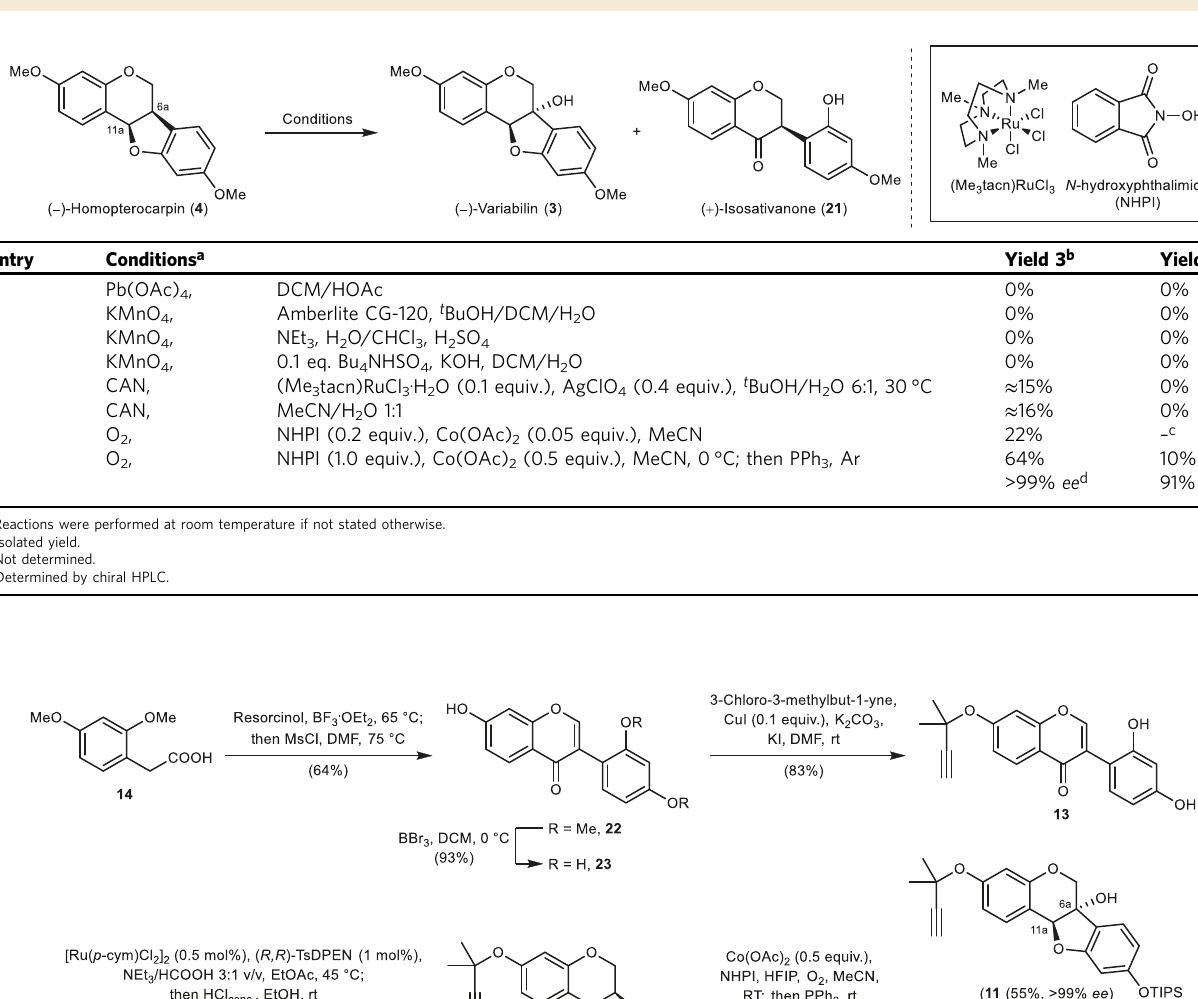
Table 1 Benzylic oxidation of ( − )-homopterocarpin (4).